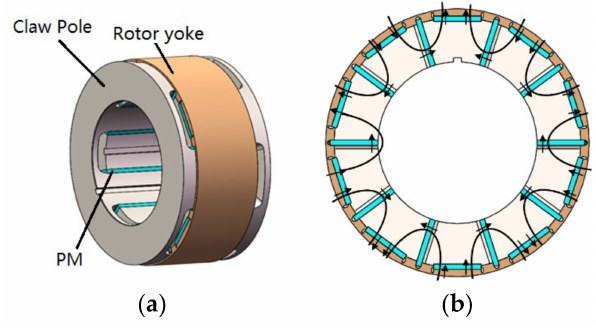
Figure 1. Exploded view of hybrid excitation claw pole generator (HECPG).